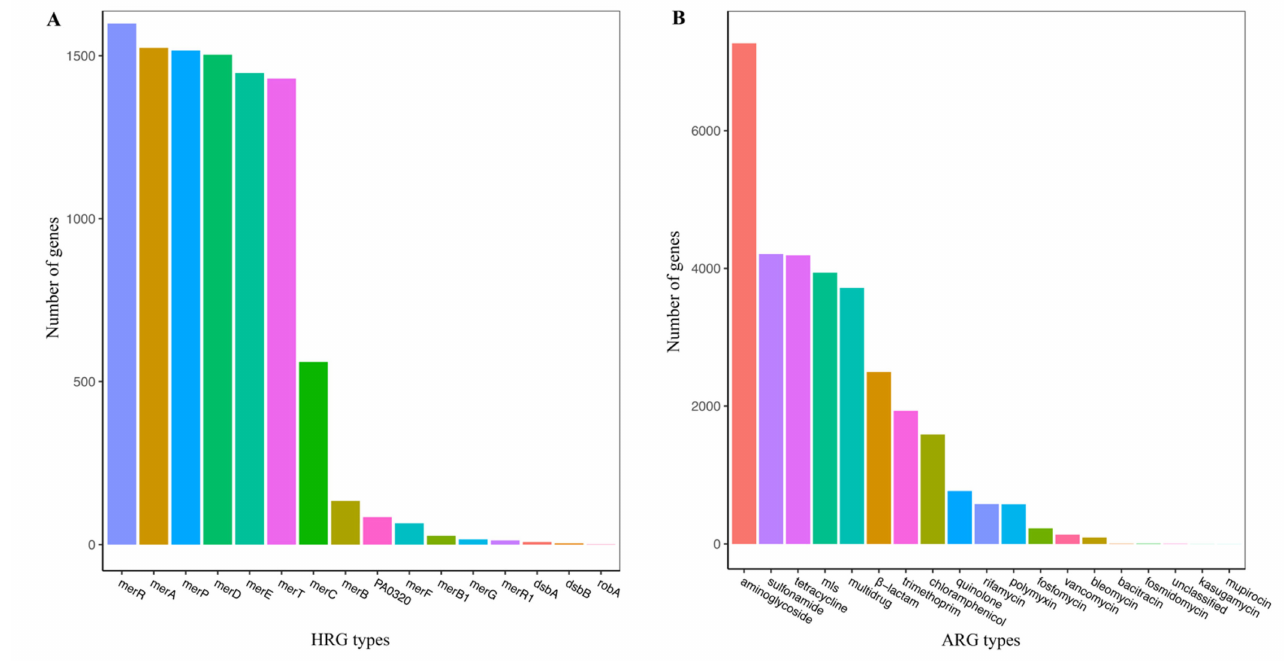
Figure 1. Distribution of the HRG ( A ) and ARG ( B ) classes in all analyzed plasmids. mls: macrolide − lincosamide −